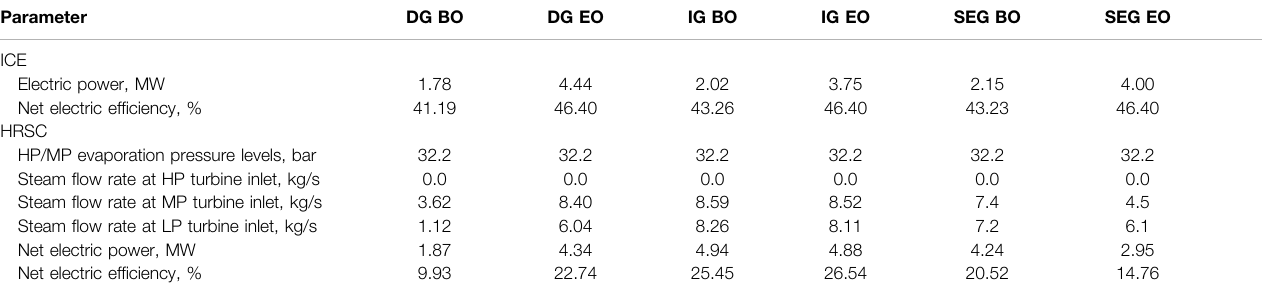
Parameter DG BO DG EO IG BO IG EO SEG BO SEG EO ICE Electric power, MW